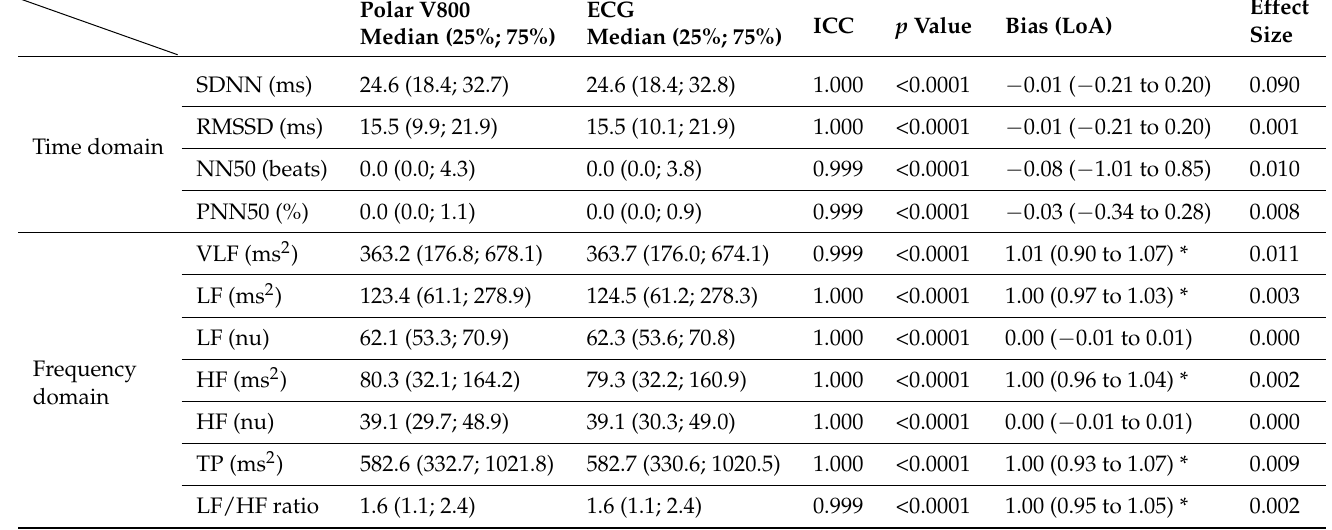
Table 5. HRV parameters for naming test.